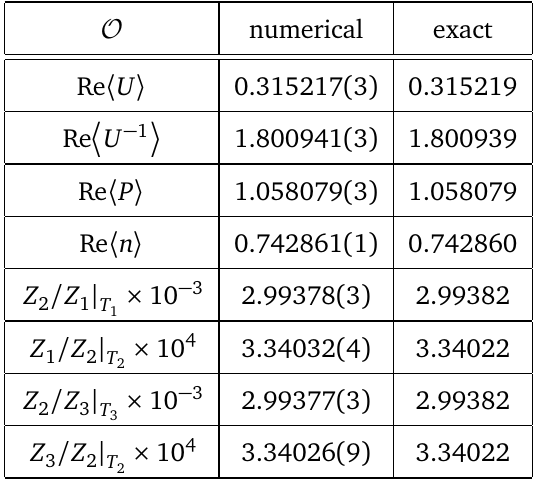
Figure 5: Complex plane with thimble structure and drift of the U(1) one link model. Note that due to periodicity the green thimbles (full vertical lines) which are not contributing are actually the same. Table 2: Numerical results and exact values of observables for the U(1) model with statistical errors. Note that the imaginary parts for the observables are all consistent with zero within the statistical error. Possible deviations are caused by numerical discretization errors, see main text for a detailed